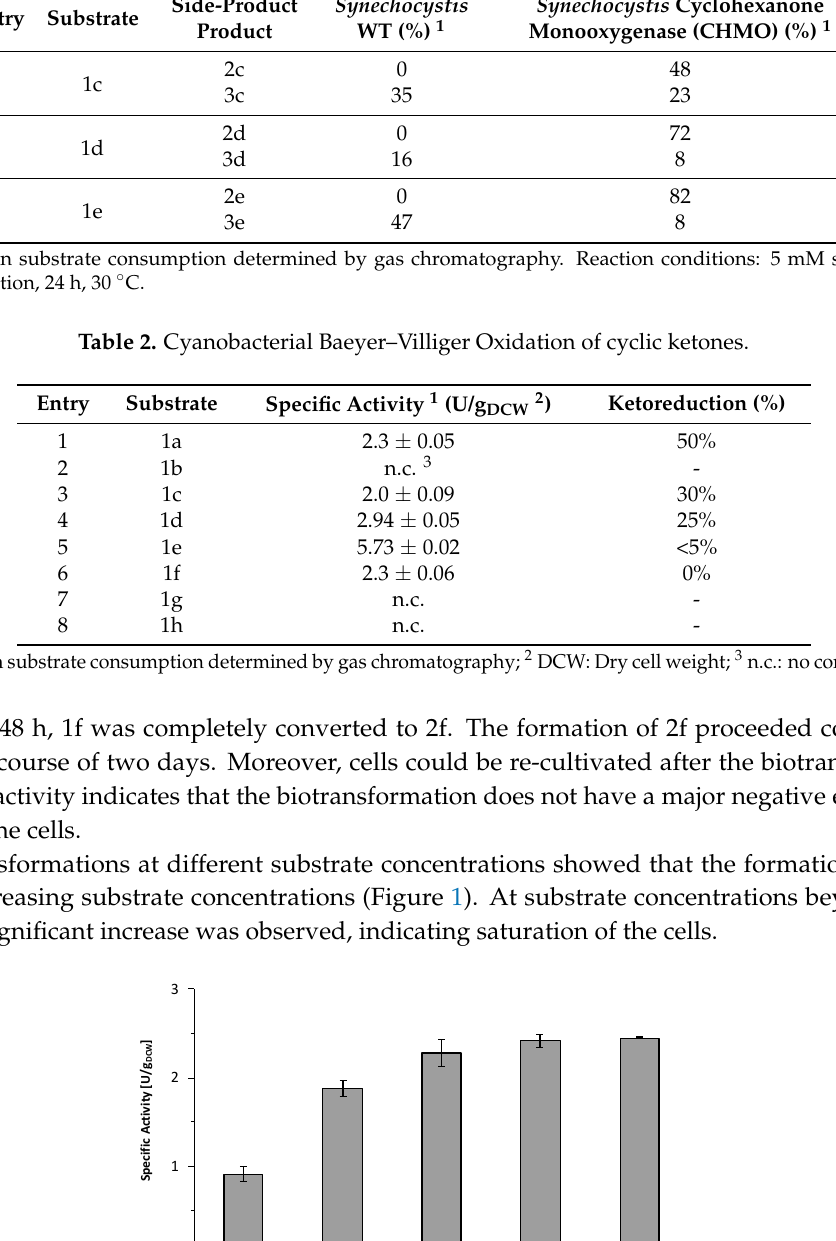
Table 1. Conversions for cyanobacterial ketoreduction by endogenous alcohol dehydrogenases with methylated cyclic ketone substrates.